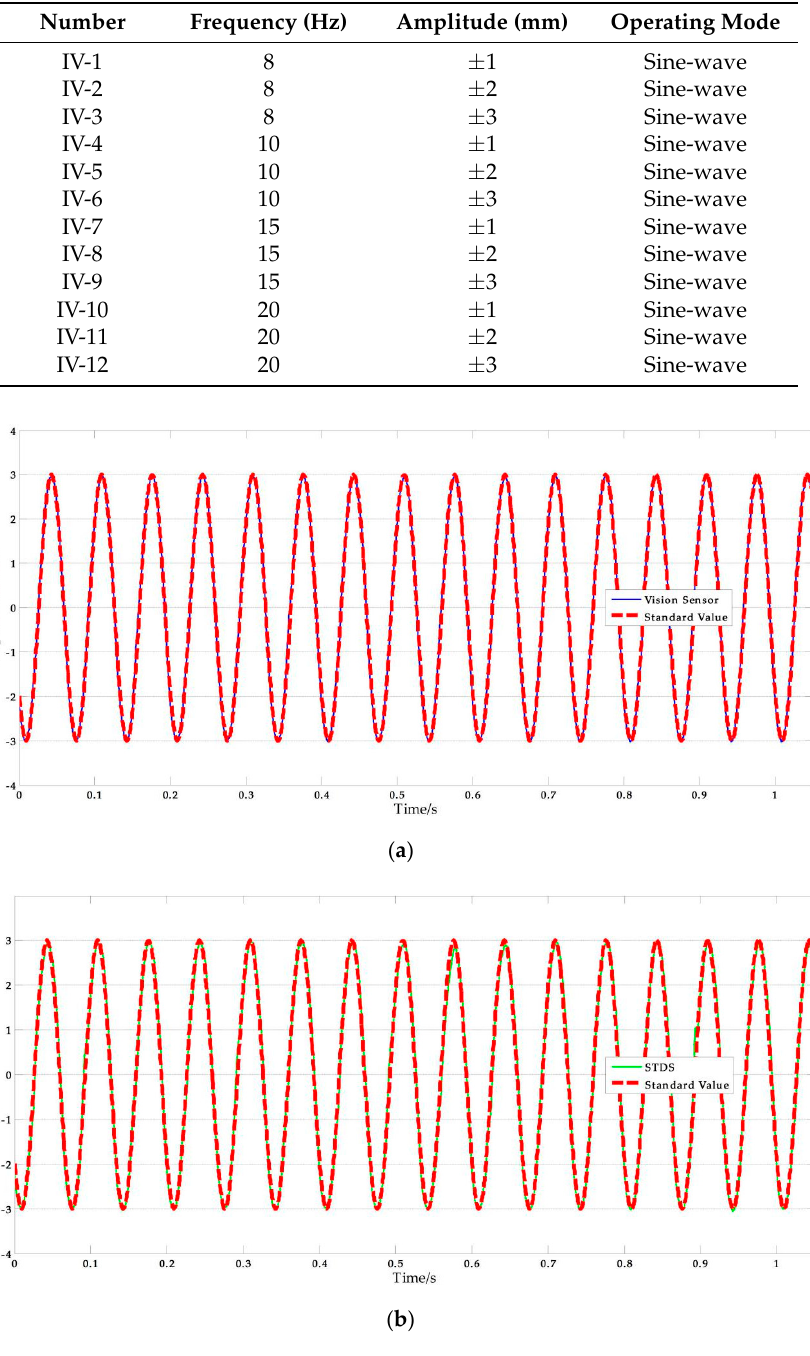
Figure 16. Shaking table test results: ( a ) Measurement results of vision-sensor compared with standard values; ( b ) Measurement results of STDS compared with standard values. ( f = 15 Hz, A = 3 mm).